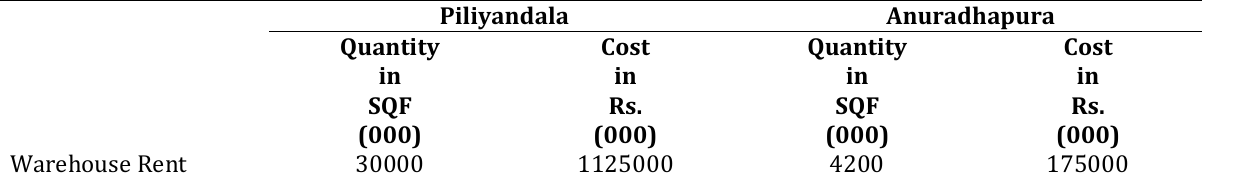
Table 7: Rental cost on Piliyandala and Anuradhapura depot